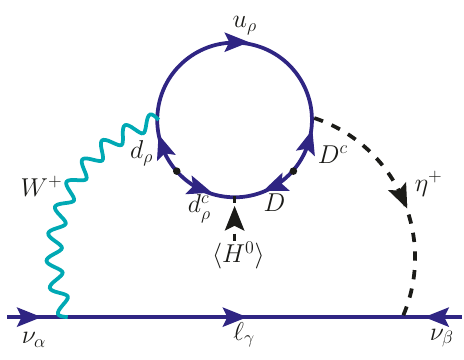
Figure 48 . Two-loop neutrino mass generation with singlet scalar and vector-like quark, corre- 1 sponding to or table 3 3 O